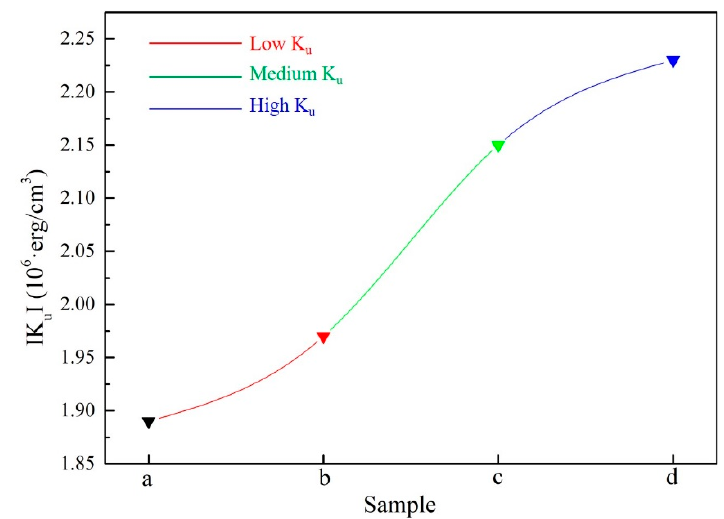
Figure 10. The Ku value of study